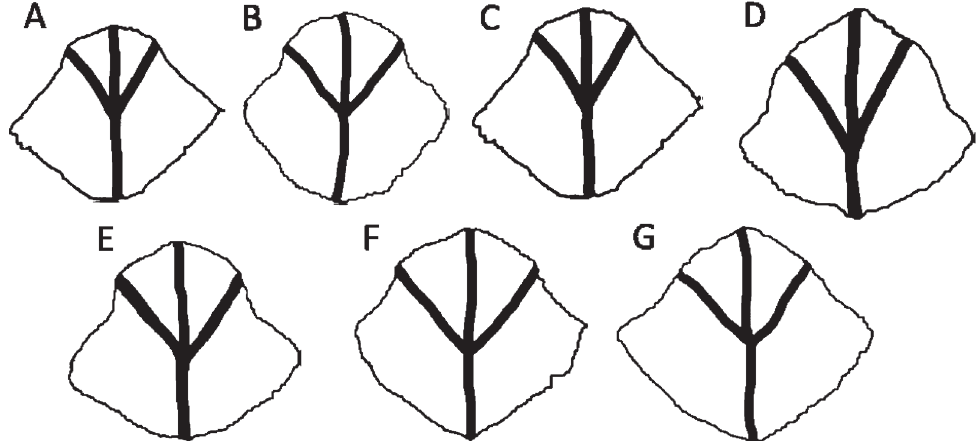
Figure 9. Entoplastron bones of Chrysemys picta bellii. A, Neb 3; B, Neb 4; C, Neb 5; D, Neb 12; E, Neb 13; F, Neb 14; and G, ODFW 1.